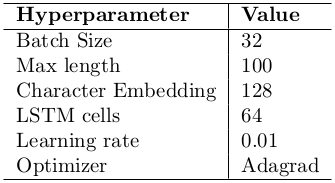
Table from the paper: An Ensemble Model for Sentiment Analysis of Hindi-English Code-Mixed Data
Table text:
Hyperparameter
Value
BatchSize
32
Maxlength
100
CharacterEmbedding
128
LSTMcells
64
Learningrate
0.01
Optimizer
Adagrad